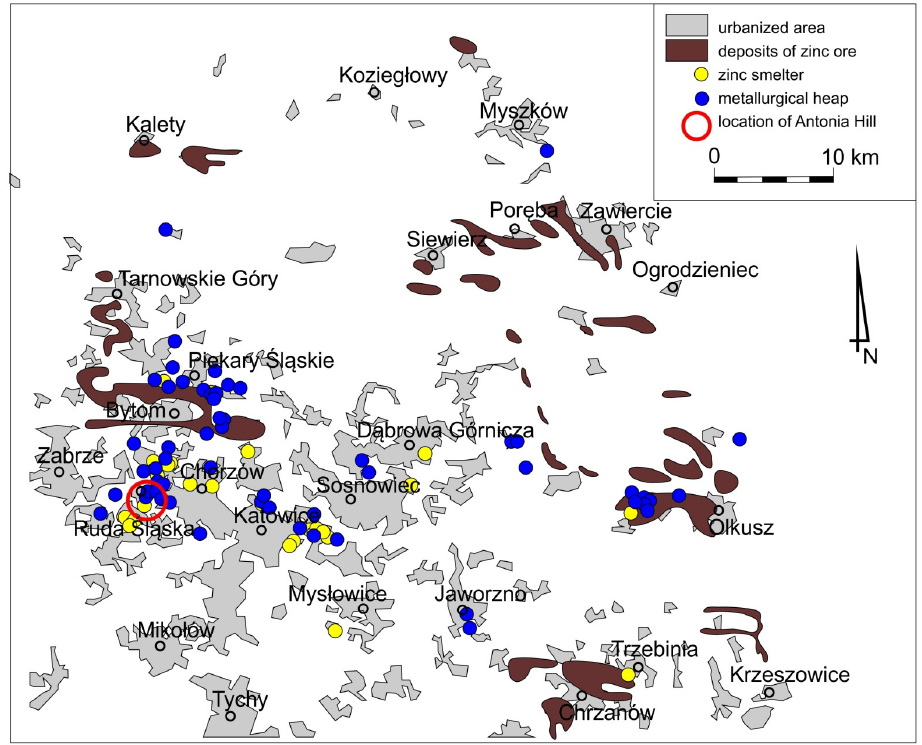
Figure 2. Historical locations of zinc ore deposits, smelters, and metallurgical heaps in Upper Silesia, Poland (compiled after: [49,61,72]).